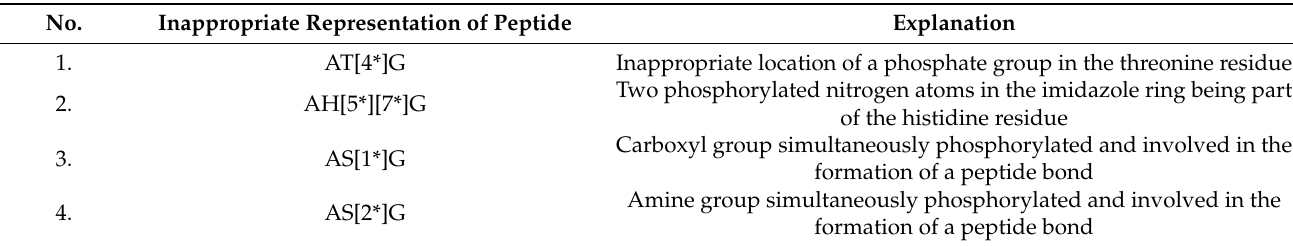
Table 4. Examples of possible errors in peptide